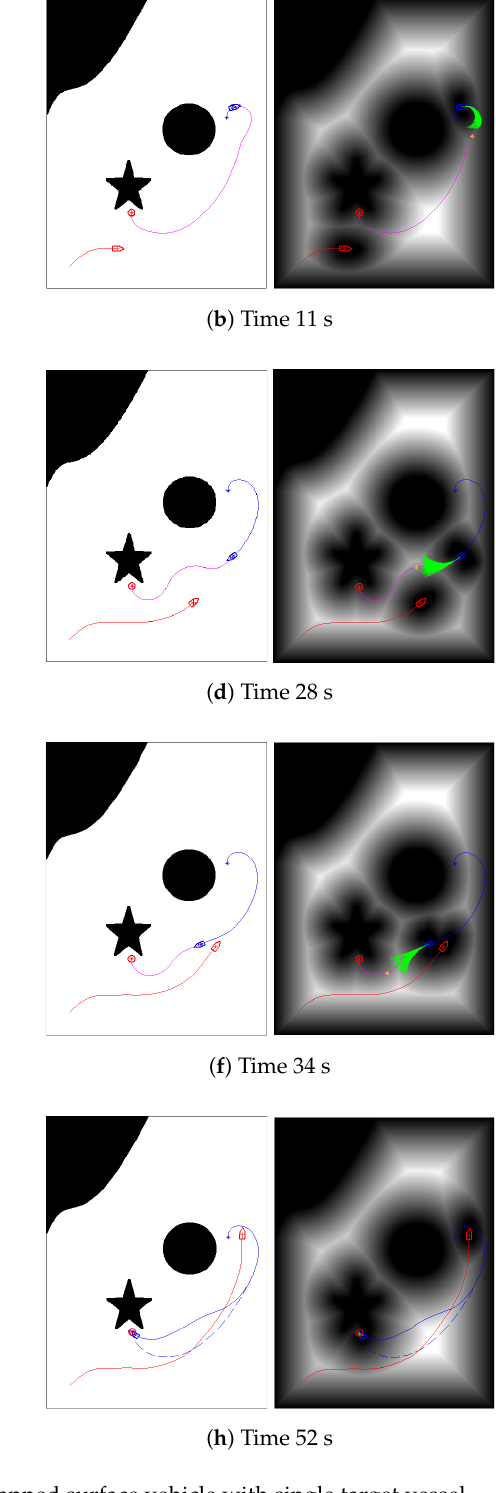
Figure 18. The motion sequence diagram of the unmanned surface vehicle with single target vessel in the simulation environment. ( a ) Time 3 s; ( b ) Time 11 s; ( c ) Time 20 s; ( d ) Time 28 s; ( e ) Time 31 s; ( f ) Time 34 s; ( g ) Time 43 s; ( h ) Time 52